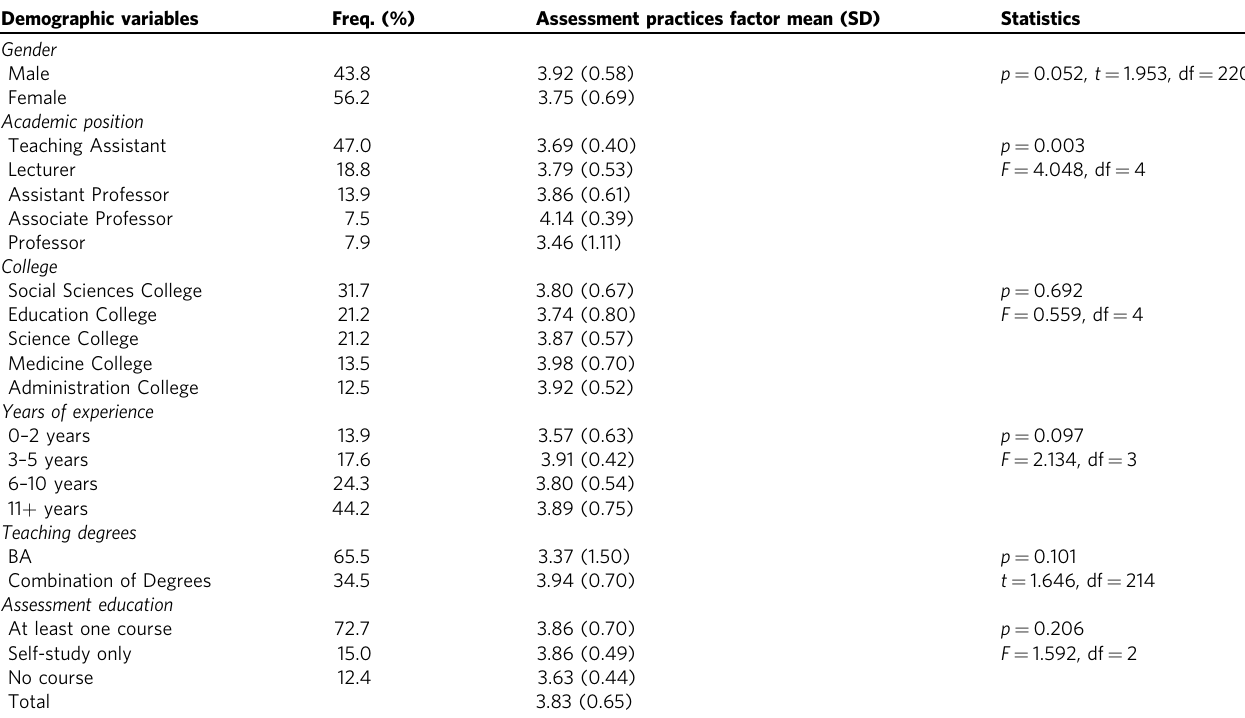
Table 4 Frequency and statistical comparisons of the relationship between demographic variables and assessment